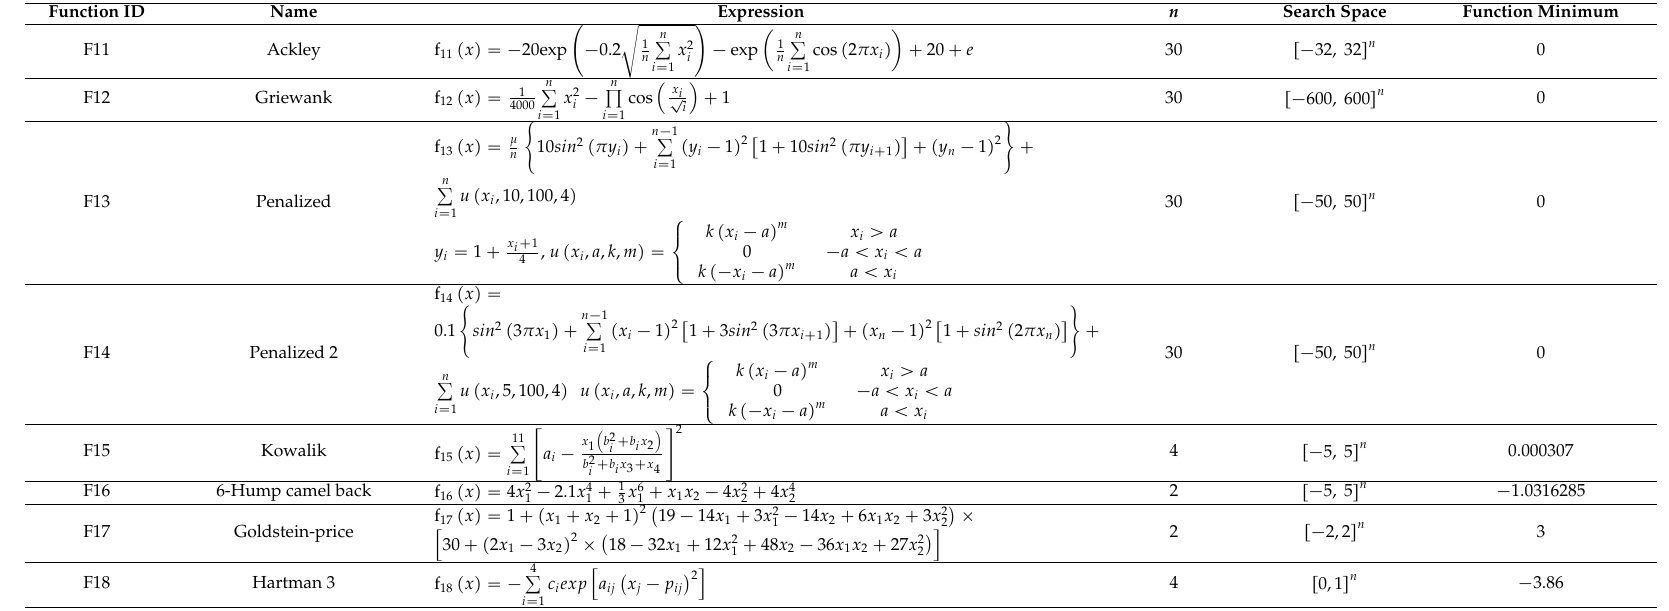
Table 9. Multimodal and non-separable test